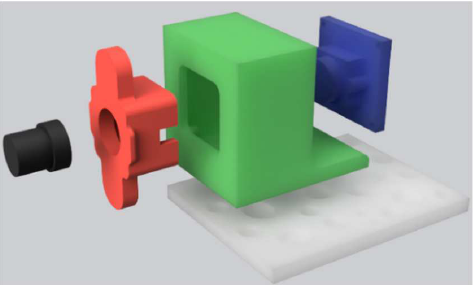
Figure 3. Digital microscope and its magnetic support. The microscope is composed of a photo sen- sor (blue) fixed on the green support with four screws, as well as the lens support (red) placed in front of the sensor and holding an inverted camera lens (black) that allows a 50× optical magnifica- tion. The camera is placed on the white magnetic support fixed on the X axis of the 3D printer. The camera support has been 3D printed in translucent ABS using a Prusa I3 MK3 (nozzle: 250 °C, Bed: 100 °C, nozzle: 0.4 mm, layer height: 0.2 mm, filling: 100%). The lens must be perpendicular to the sensor to avoid optical aberrations on the edge of the images.